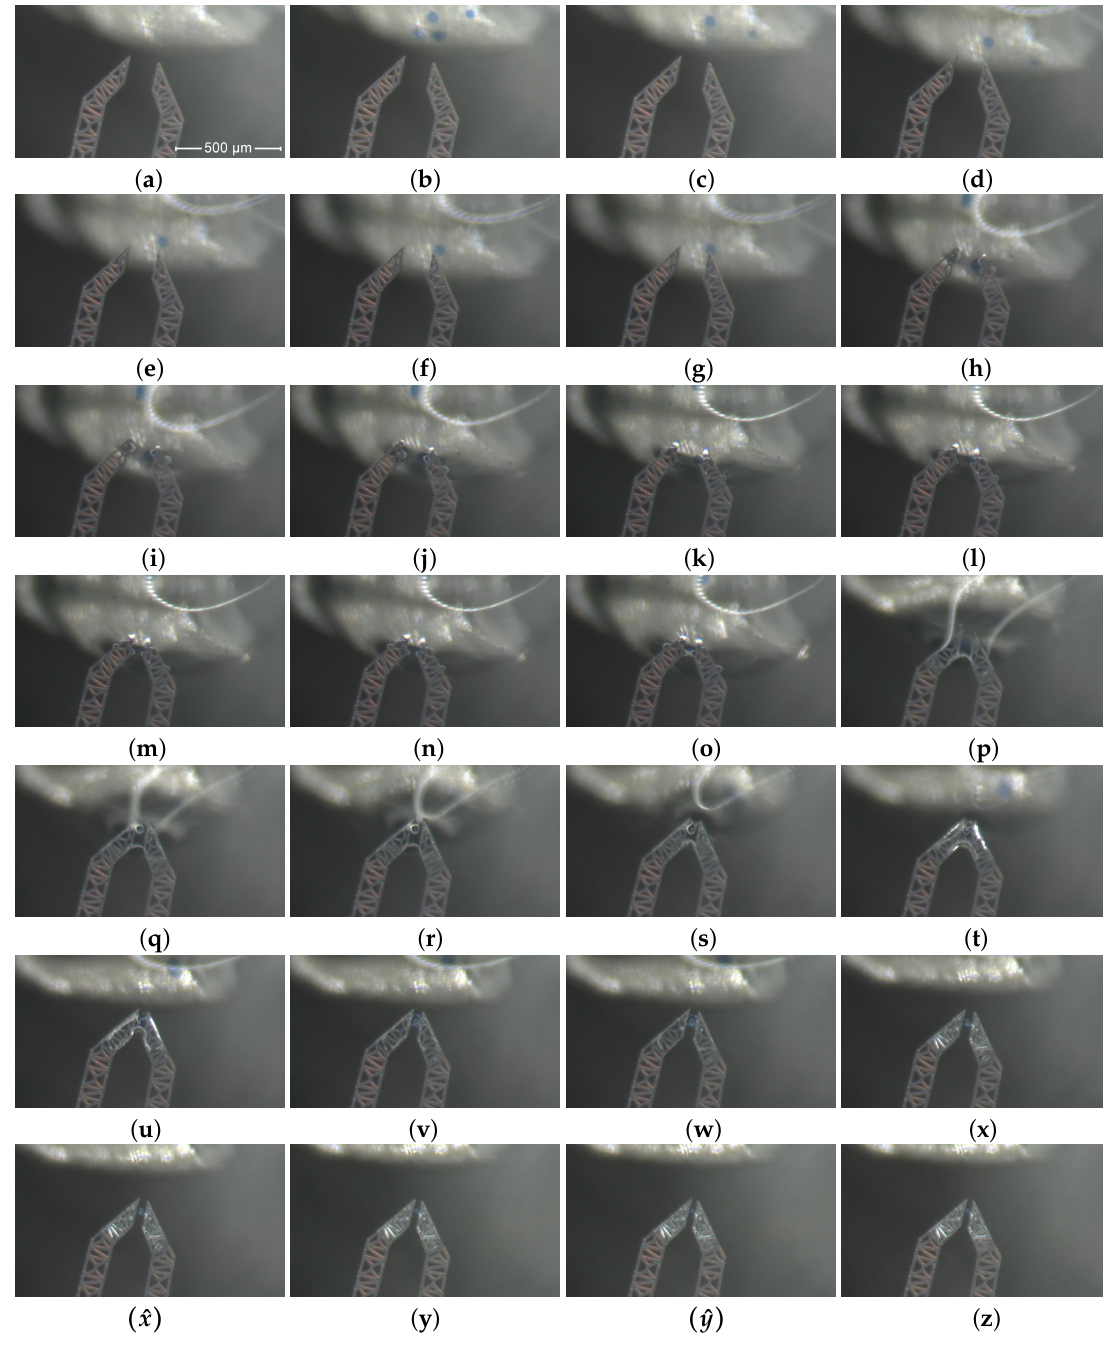
Figure 5. A complete grasping sequence: approaching, from ( a ) to ( f ); contact and insertion, from ( g ) to ( k ); grasping ( l ); exit from the drop, from ( m ) to ( p ); extraction, ( q ), ( r ) and ( s ); residual water evaporation from the jaws, from ( t ) to ( v ); bead progressive grasping and agarose shrinking, from ( w ) to ( z